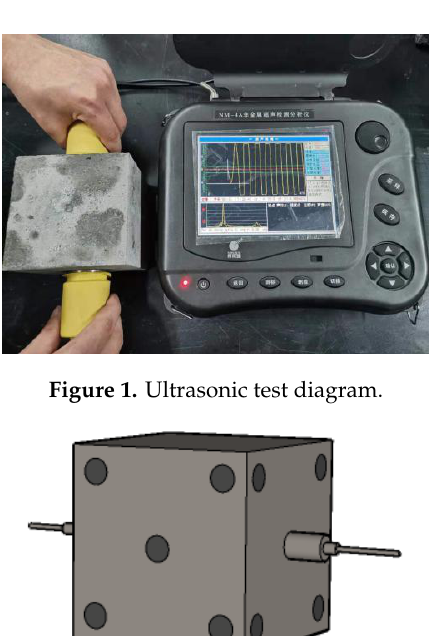
Figure 4. Stress model and loading path of specimen. 3. Results and Discussions 3.1. Compressive Strength As the basic index value of mechanical properties of SCC, compressive strength was also the basis for the study of other mechanical indexes. The results of SCC compressive strength test at different ages are shown in Figure 5. The average values and standard deviation of the test are shown in Tables 4 and 5.